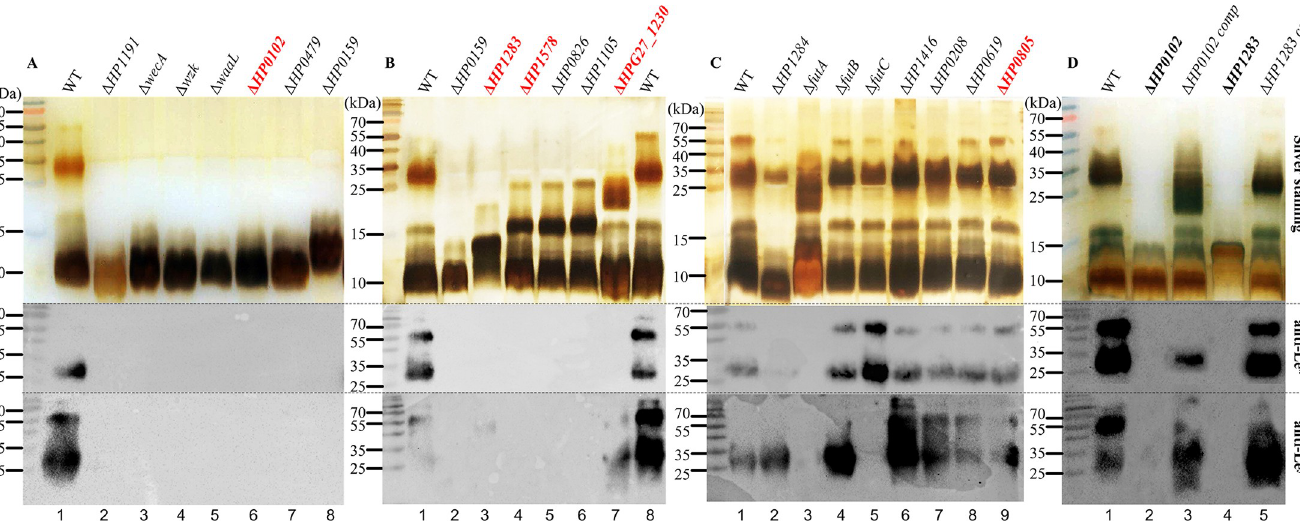
Fig 2. Systematic mutational analysis of LPS genes in G27. LPS samples from G27 wild-type and isogenic LPS mutants were analysed by silver staining (upper panel), and Western blot using anti-Le x (middle panel) and anti-Le y antibodies (lower panel). ( A ): Lane 1: G27 wild-type full-length LPS expressing both Le x and Le y ; Lane 2: the Hep II transferase mutant Δ HP1191 ; Lane 3–5: the O-antigen initiating enzyme (WecA), flippase (Wzk), and ligase (WaaL) mutants; Lane 6: the new glycosytransferase gene mutant Δ HP0102 ; Lane 7: the Trio Hep transferase mutant Δ HP0479 ; Lane 8: the glucan transferase mutant Δ HP0159 ; ( B ): Lane 1–2: G27 wild- type and Δ HP0159 ; Lane 3–4: the new glycosytransferase gene mutants Δ HP1283 and Δ HP1578 ; Lane 5–6: the poly-LacNAc Gal and GlcNAc transferase mutants Δ HP0826 and Δ HP1105 ; Lane 7: the new glycosytransferase gene mutant Δ HPG27_1230 ; Lane 8: G27 wild-type; ( C ): Lane 1–9: G27 wild-type, the Hep III transferase mutant Δ HP1284 , Δ futA , Δ futB , Δ futC , Δ HP1416 , Δ HP0208 , Δ HP0619 , and the new glycosyltransferase mutant Δ HP0805 ; ( D ): Lane 1, G27 wild-type; Lane 2–3, Δ HP0102 and Δ HP0102 complementation; Lane 4–5, Δ HP1283 and Δ HP1283 complementation.